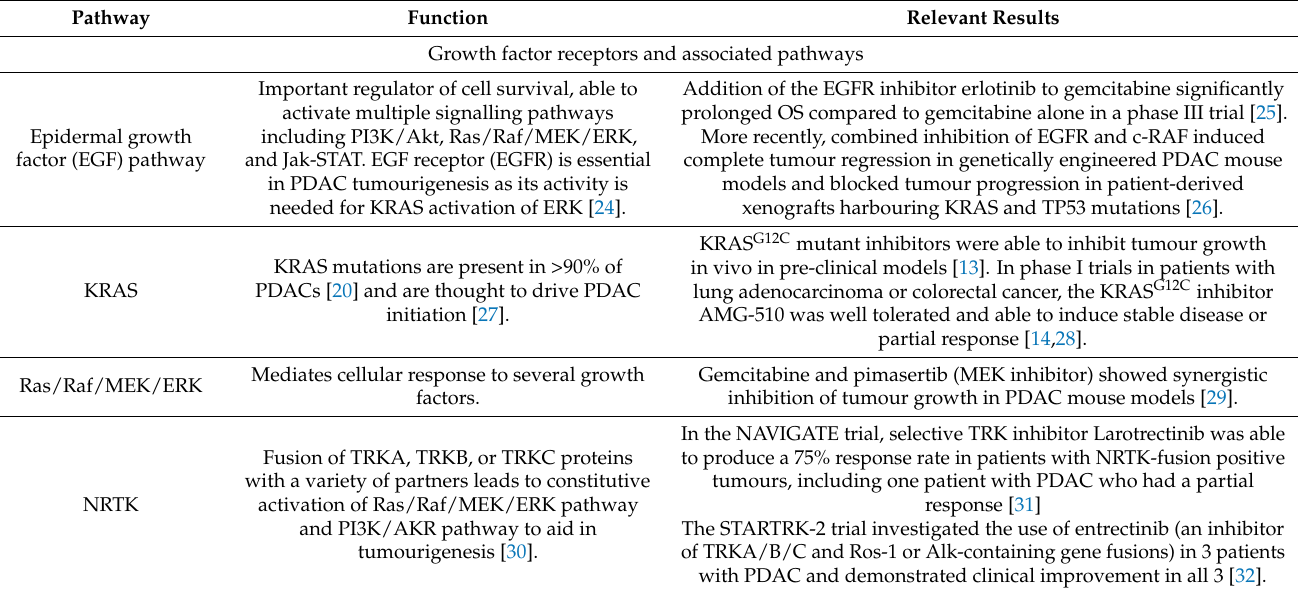
Table 2. Pathway inhibition strategies in